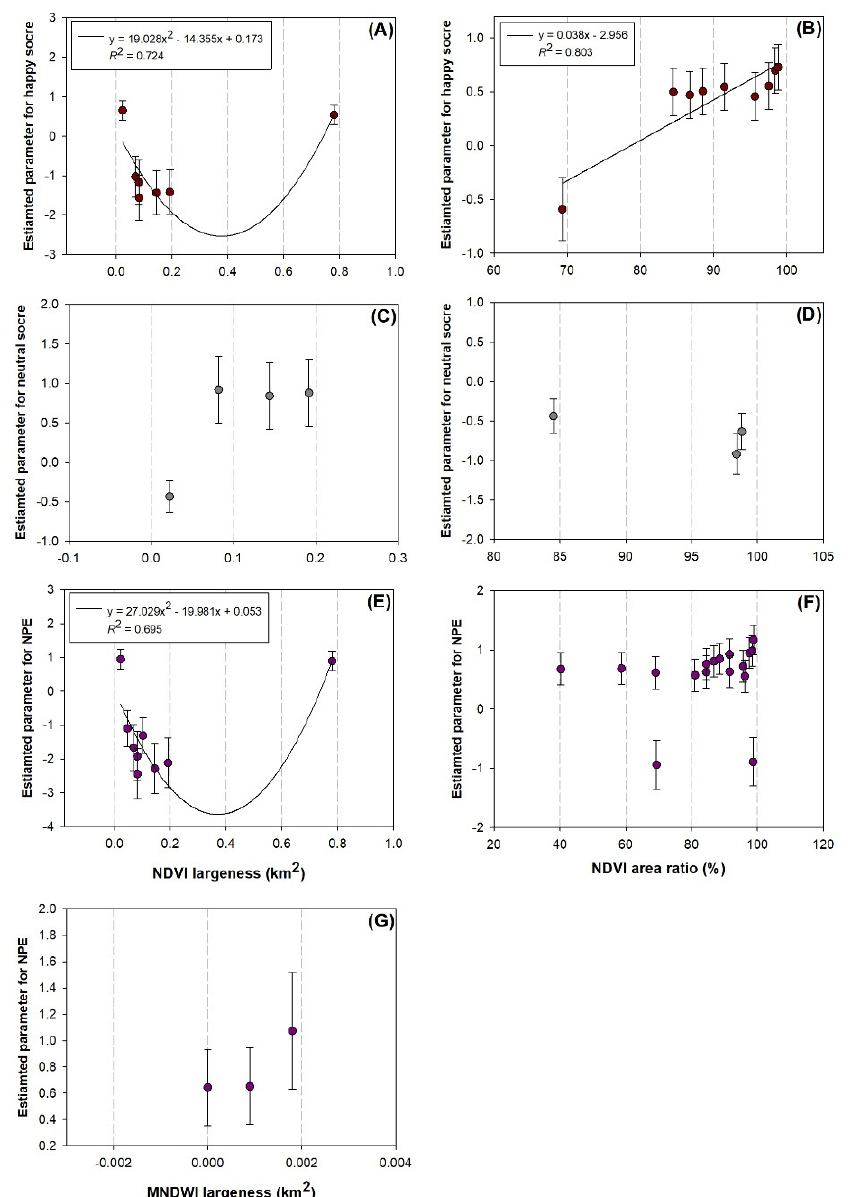
Figure 5. Poisson regression of facial expression scores for happy ( A , B ) and neutral ( C , D ) emotions and NPE ( E , F ) against NDVI largeness ( A , C , E ) and NDVI area ratio ( B , D , F ) or for NPE against MNDWI largeness ( G ). Dots are parameters (coefficients) estimated by maximum likelihood in Poisson models with error bars marking standard deviations against observed landscape metric largeness. Polynomial quadratic or linear equations are given based on significant correlation ( p < 0.05) with determinative coefficient ( R 2 )